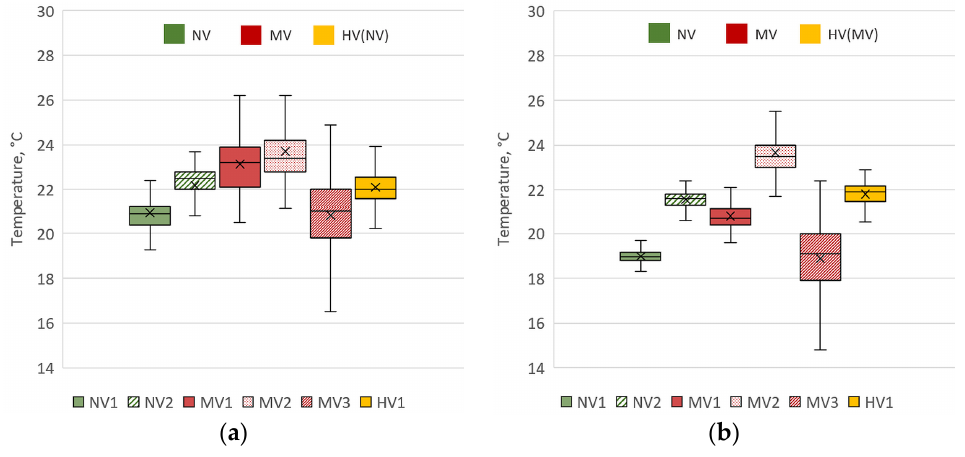
Figure 3. Bedroom temperature, hours 11 pm–7 am: ( a ) summer–autumn; ( b ) winter. The lowest average air temperatures in the bedrooms were recorded in the NV1 and MV3 buildings and are, respectively, 21.0 °C and 20.8 °C for the warm season and 18.8 °C and 18.9 °C for the winter season. The largest temperature fluctuations occurred in the MV3 building, which resulted from the frequent opening of windows by residents, discussed later in the study. The low average temperature in the NV1 bedroom has different contributing causes for each of two periods analyzed, with the exception of its ground floor location, previously linked with overall more stable and lower internal temperatures [16] than on higher floors.